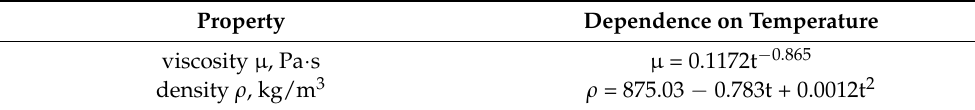
Table 3. Characteristics of oil Velol-9Q.